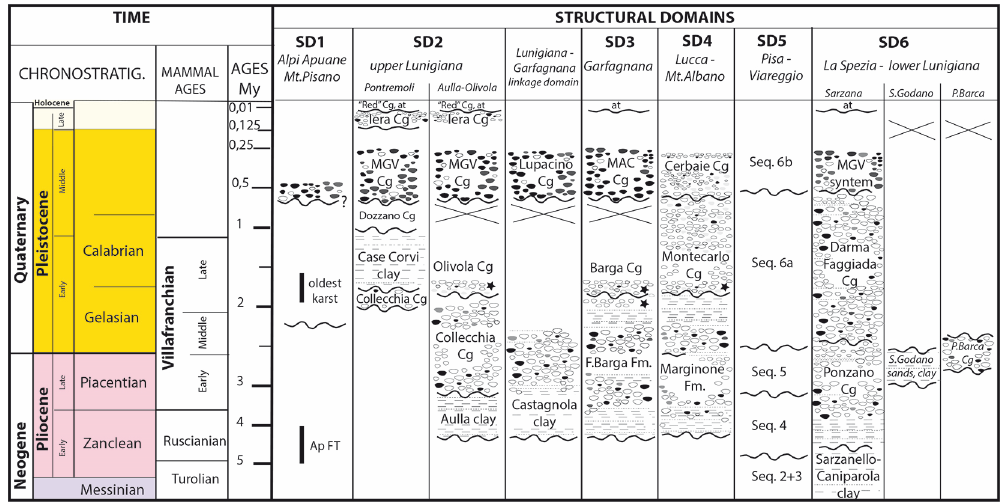
Figure 2. Schematic frame and correlations of continental–marine Plio-Quaternary sedimentary successions in the different structural domains described (MGV and MAC mean Magra Valley and Macigno-rich conglomerates, respectively).